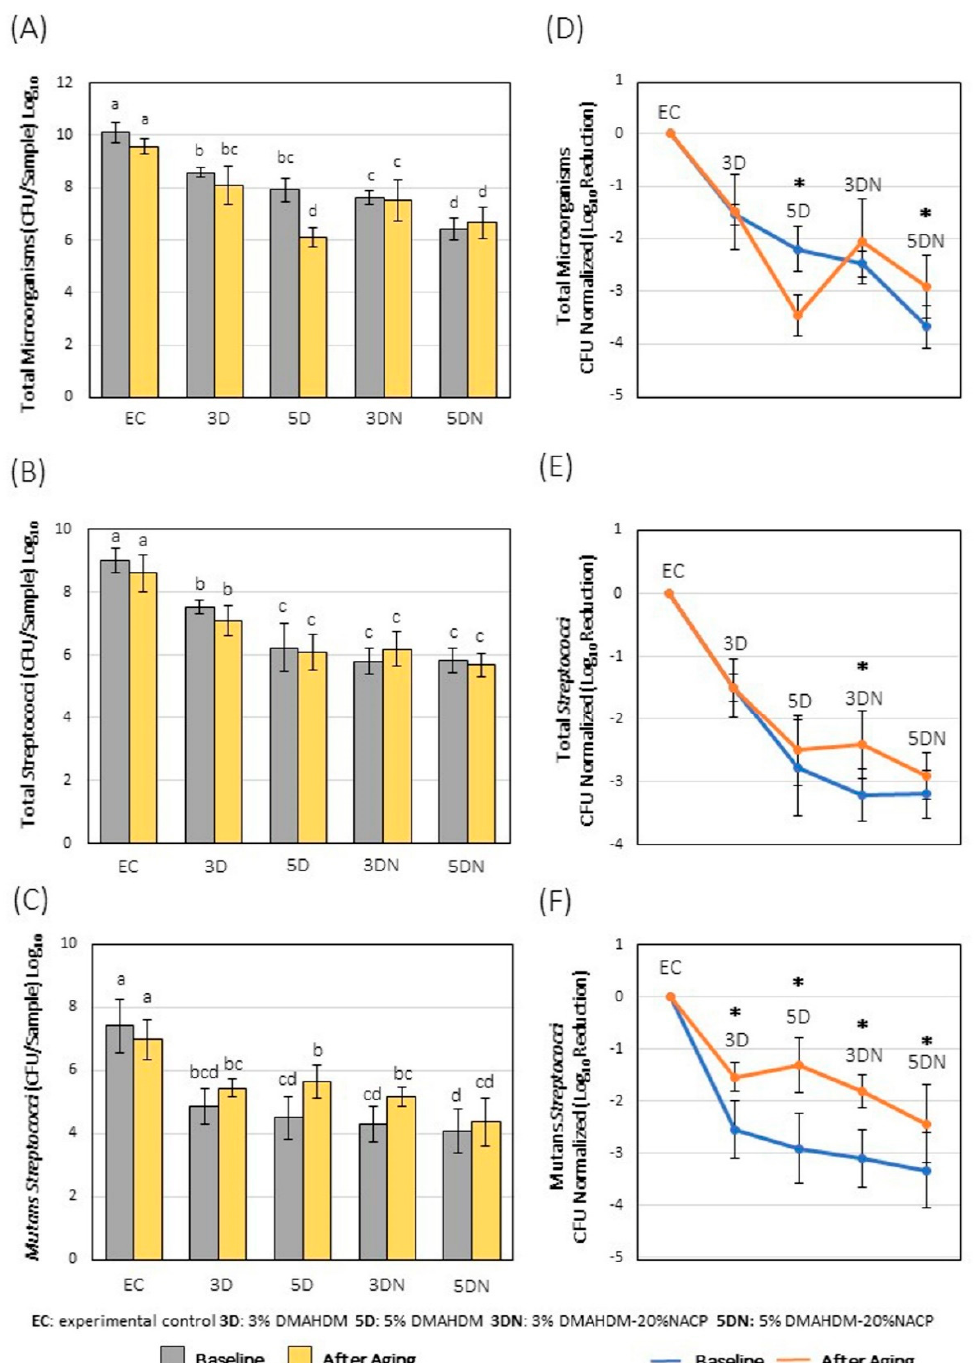
Figure 3. Colony-forming unit (CFU) counts of the ( A ) total microorganisms, ( B ) total streptococci, and ( C ) mutans streptococci on the composite surface (mean ± SD; n = 9). Different letters indicate significant differences between groups ( p < 0.05). The difference in the log reduction between the baseline and aged samples concerning the ( D ) total microorganisms, ( E ) total streptococci, and ( F ) mutans streptococci is illustrated. * Asterisks indicate significant differences compared to baseline values before aging. (EC = experimental control; 3D = 3% DMAHDM; 5D = 5% DMAHDM; 3DN = 3% DMAHDM-20% NACP; 5DN = 5% DMAHDM-20% NACP).